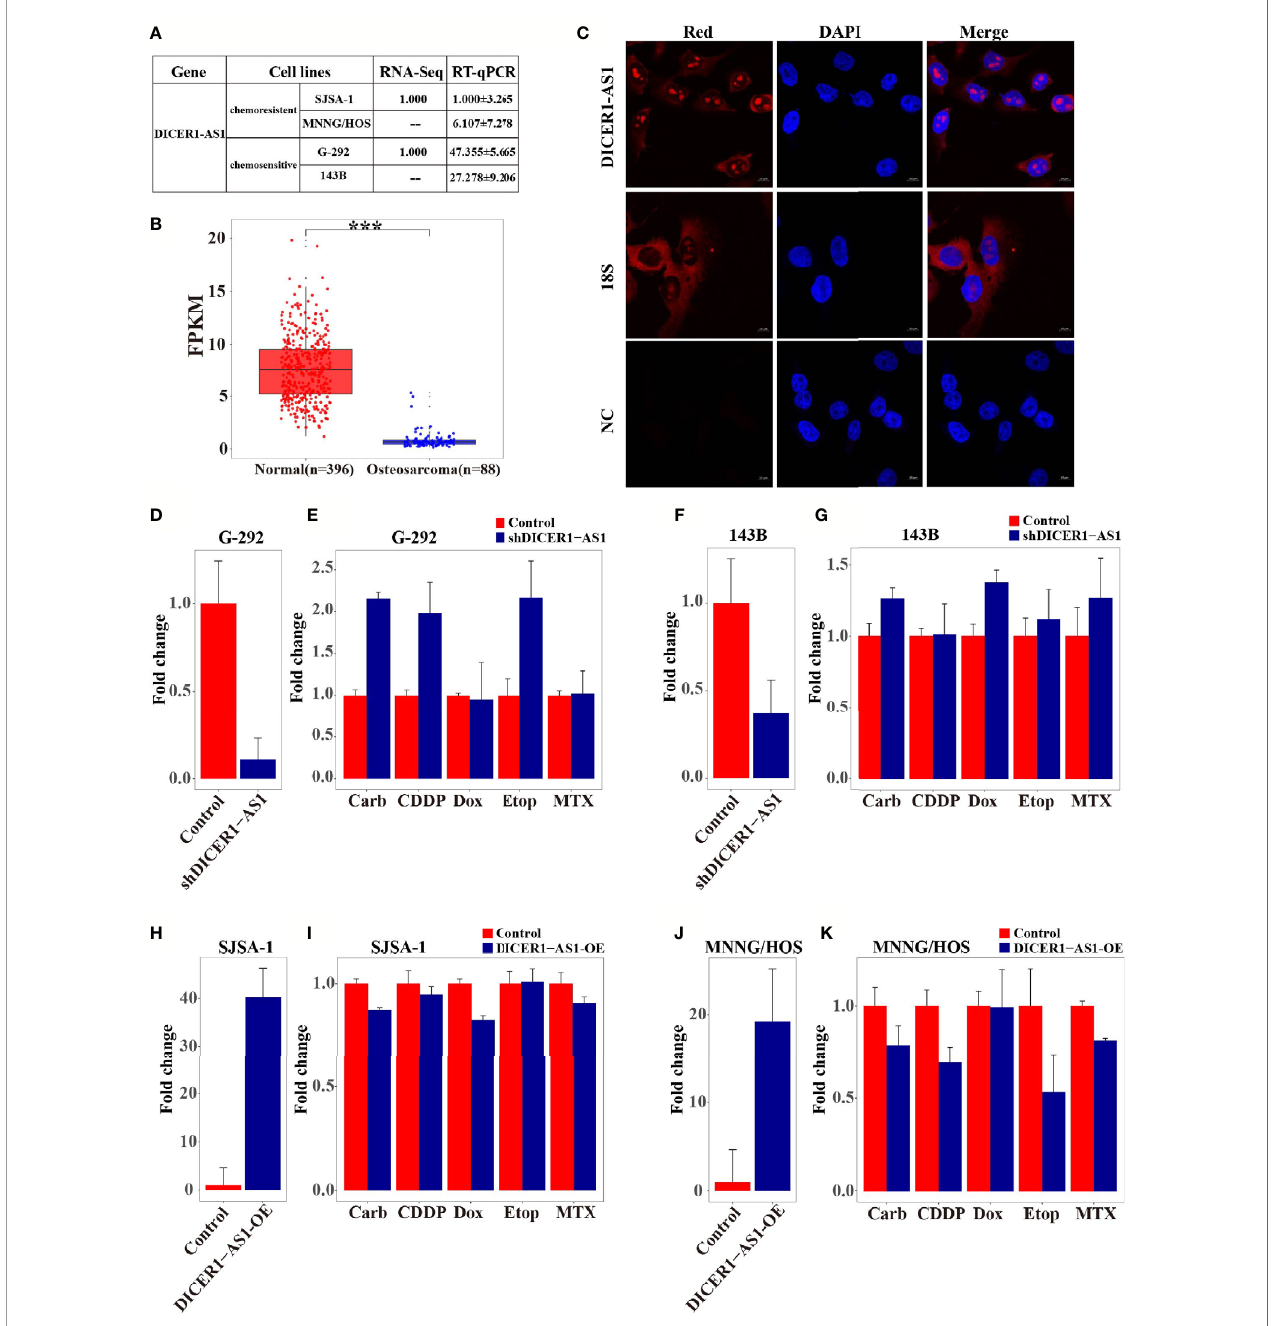
FIGURE 1 | DICER1-AS1 is involved in the regulation of OS cells drug resistance. (A) The relative lncRNA-seq and real-time PCR analyse level (fold) of DICER1-AS1 in drugsensitive G-292 and 143B cells versus drugresistant SJSA-1 and MNNG/HOS cells. (B) Relative expression levels of the DICER1-AS1 FPKM data in 88 cases osteosarcoma cancer samples and 396 cases surrounding normal tissues. (C) RNA fl uorescence in situ hybridization showing the localization of DICER1-AS1 in G- 292 cells. Cells were incubated with DICER1-AS1 sense probes (5' GCCCA+A+CGCCA+AGGTCCA+GTCCA 3'). After DAPI staining, fl uorescence was observed under a fl uorescence microscope. Scale bar, 25 m m. (D, F) The relative DICER1-AS1 expression level (fold) in G-292(D) and 143B(F) cells transfected with shDICER1- AS1 versus the negative control(NC). (E, G) CCK8 assay showing cell death triggered by an IC 50 dose of drug in G-292 (E) and 143B (G) cells transfected with shDICER1-AS1 versus the negative control(NC) assayed 72 h after treatment with the IC 50 dose of drugs. (H, J) The relative DICER1-AS1 expression level (fold) in SJSA-1(H) and MNNG/HOS(J) cells infected with DICER1-AS1-OE versus the negative control (NC). (I, K) CCK8 assay showing cell death triggered by an IC50 dose of drug in SJSA-1(I) and MNNG/HOS(K) cells infected with DICER1-AS1-OE versus the negative control(NC) assayed 72 h after treatment with the IC 50 dose of drugs. The data are mean±SD of three separate experiments. “ - ” indicates no detection in the array analysis. ***p value <